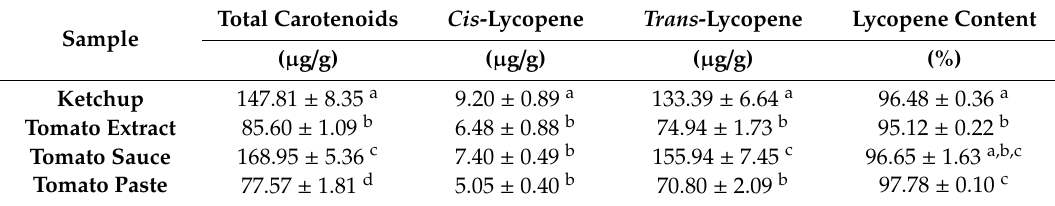
Table 1. Total carotenoid content, cis-lycopene, and all-trans-lycopene isomers from the analyzed tomato-based food